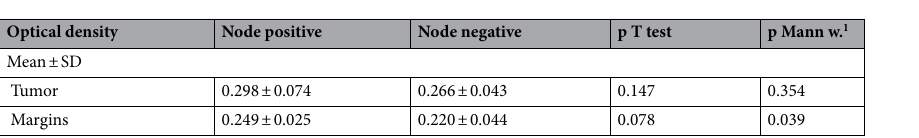
Table 2. Expression of NF-κB levels in colonic tissues of CRC patients. Comparison between patients with or without positive pathological lymph nodes. 1 Mann–Whitney U test.